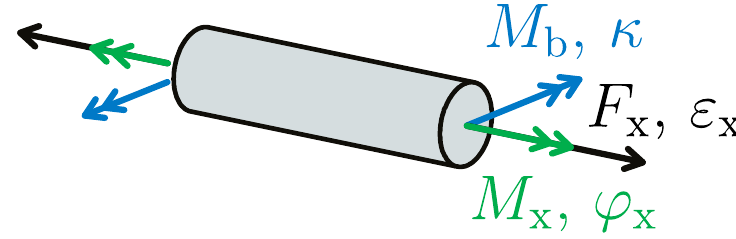
Figure 2. Definition of the loads and strains of a cable.